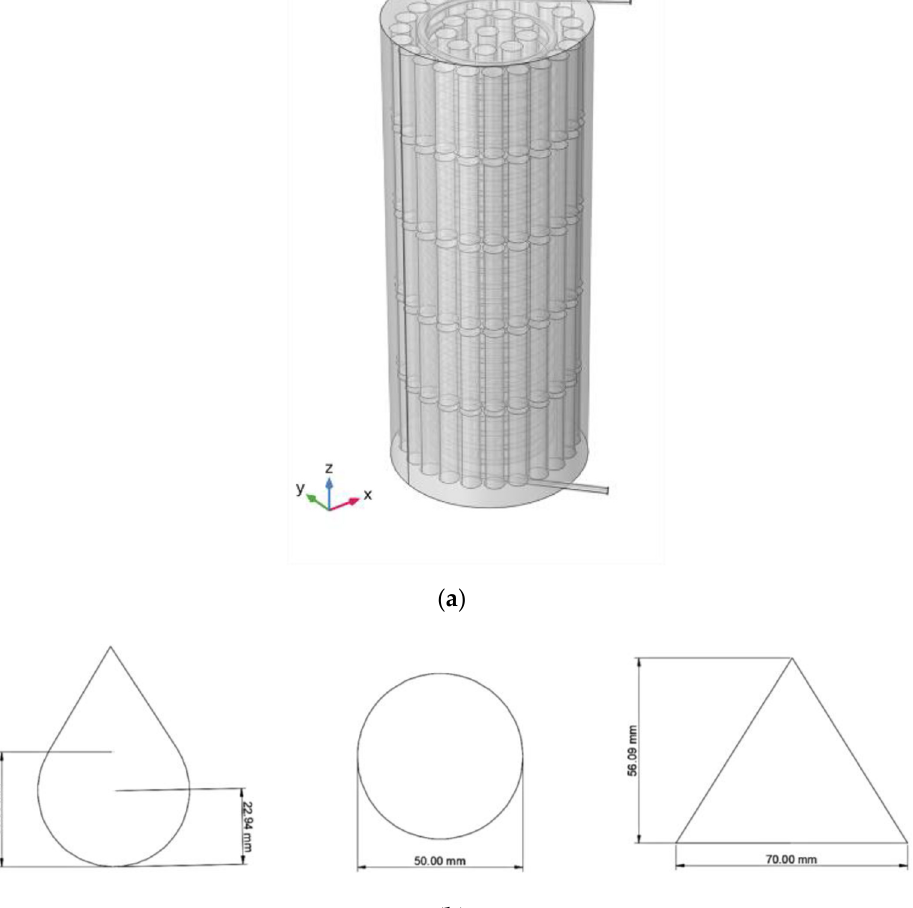
Figure 7. Macroencapsulated LHS: ( a ) LHS geometry, ( b ) cross-section shapes of the contain- ers (Copyright 2021 Bernal et al. (https://creativecommons.org/licenses/by/4.0/), accessed on 26 September 2022